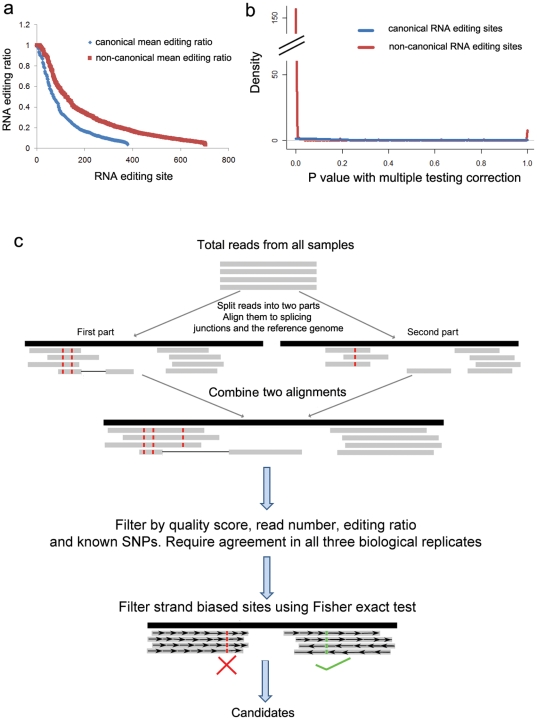
Identification of high-confidence RNA editing sites.A) Distribution of editing ratio for all observed canonical and non-canonical RNA editing sites in our adipose RNA-seq data shows that the ratio is higher for non-canonical than canonical sites. B) Distribution of Fisher's exact test p-values for strand bias. Non-canonical RNA editing sites shows an extreme peak around zero, indicating that most non-canonical RNA editing sites are supported by strand biased reads. C) Overview of our RNA editing analysis pipeline.